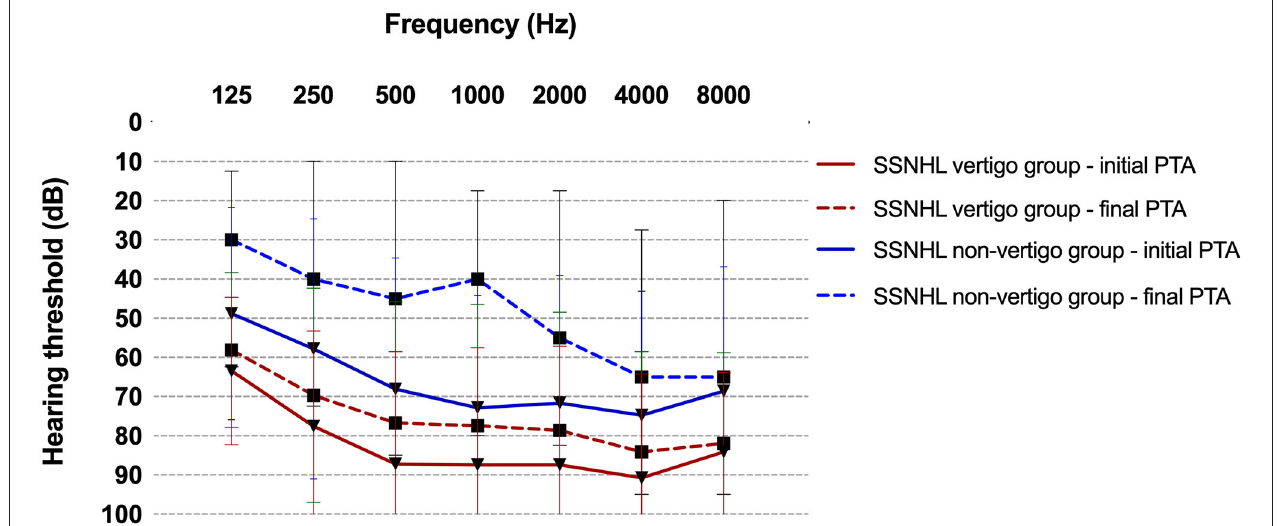
FIGURE 1 | The difference between the initial and final PTA in the SSNHL vertigo group and non-vertigo group. There was no significant difference in hearing recovery rate between the two groups ( p = 0.558). SSNHL, sudden sensorineural hearing loss; PTA, pure-tone